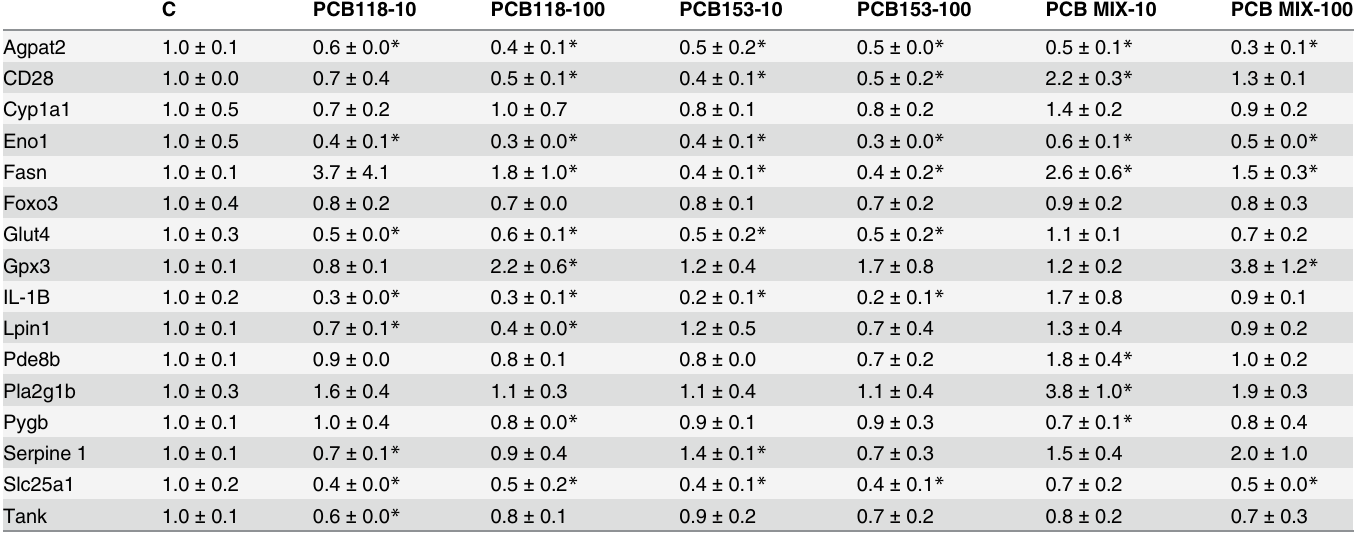
Table 9. Real-time RT-PCR validation of genes selected within the visceral adipose tissue after microarray analyses ( * p < 0.05).